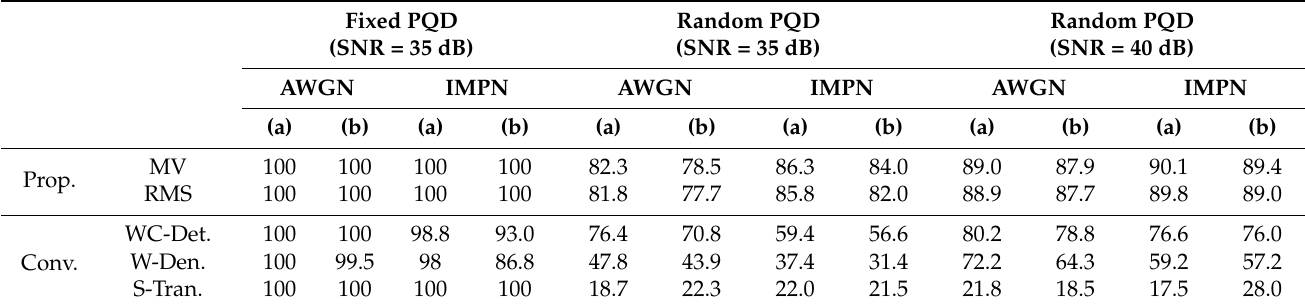
Table 5. Double-edge-based PQD detection performance (DR (%)) of the proposed and conventional (WC-Det, W-Den, and S-Transform) algorithms, where (a) a sag signal with 80% pu or (b) SWELL: a swell signal with 120% pu is used over AWGN or IMPN with SNR = 35 dB or 40 dB.